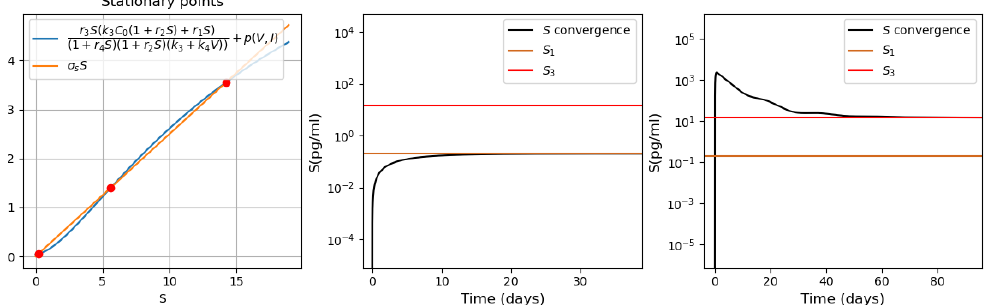
Figure 11. Left : graphical solution of Equation (32) in the bistable case. Middle : convergence of proinflammatory cytokines to the first stable stationary point, C ( 0 ) = 0. Right : convergence of proinflammatory cytokines to the second stable stationary point, C ( 0 ) = 10 3 . The values of parameters: r 1 = 3, r 2 = 0.1, r 3 = 1, r 4 = 0.1, σ S = 0.25, p 1 = 0.4, p 2 = 10, p 3 = 0.2. Initial S = 0.